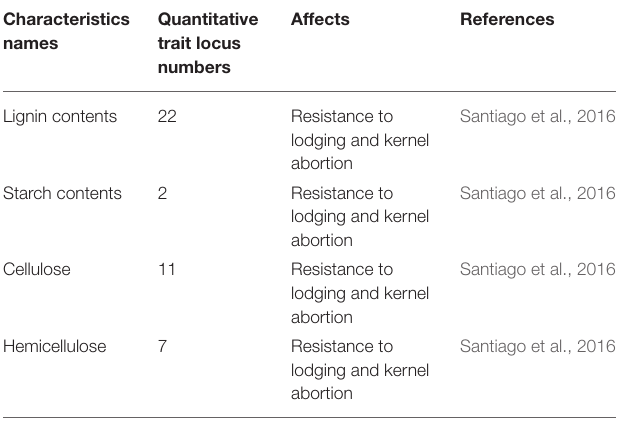
TABLE 3 | Number of quantitative trait loci identified for stem lodging resistance and kernel abortion reduction in